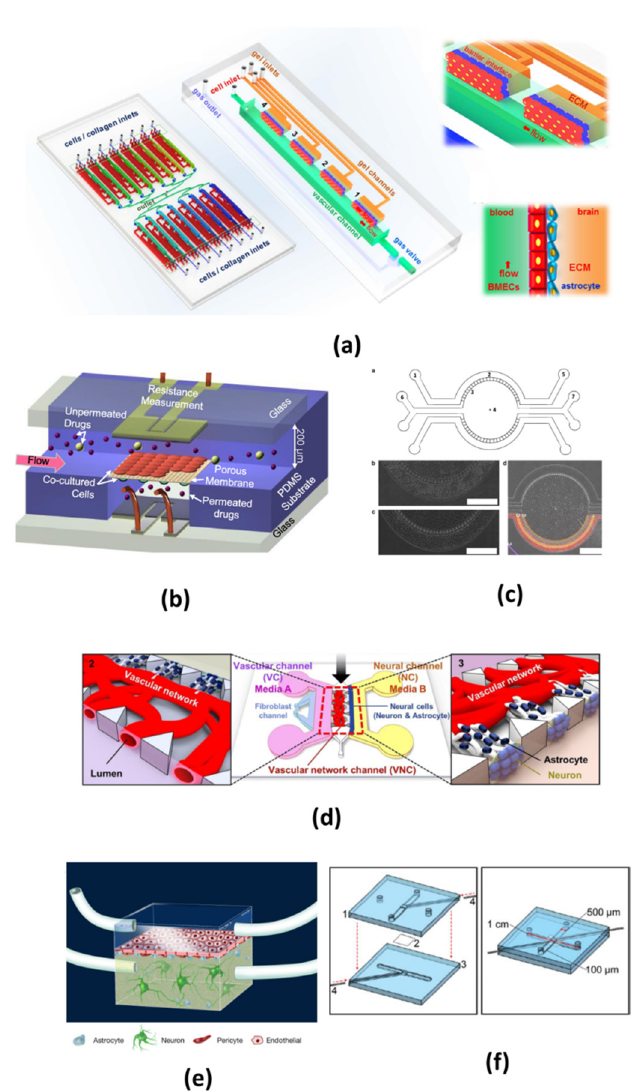
Figure 2. Typical design of microfluidic blood-brain barrier (BBB) in vitro models. ( a ) The chip is composed of 16 independent functional units. Each unit consists of four uniform BBB regions to mimic the BBB. The two pictures on the right show enlarged view and side view of the barrier regions consisting of brain microvascular endothelial cells (BMECs), astrocytes and 3D ECM under flow. (Reprinted from Reference [36] in accordance with the Creative Commons Attribution). ( b ) Multi-layered channel structure made from patterned PDMS substrate with dynamic flows, co-cultured cells and two sets of electrodes (Reprinted from Reference [58] with permission). ( c ) The chip is consisted of four channels, two central gel regions for co-culturing astrocytes and neurons, two side channel for hosting endothelial cells and medium. There are 3 µ m pores to allow di ff usion of media and tracer between the central and outer compartments, astrocytes and HUVECs were cultured in the central and outer compartment (Reprinted from Reference [59] in accordance with the Creative Commons Attribution). ( d ) In this chip, neuron and astrocytes are co-cultured in a vascular network, a system of two separate media microchannels is employed to independently emulate highly localized internal and external vascular microenvironments (Reprinted from Reference [60] in accordance with the Creative Commons Attribution). ( e ) This is a typical two-chamber system divided by a porous polycarbonate membrane. (Reprinted from Reference [61] in accordance with the Creative Commons Attribution). ( f ) A polycarbonate membrane is used to separate the top channel from the bottom channel, and Pt wire gently slide in the top and bottom groove (Reprinted from Reference [62] with